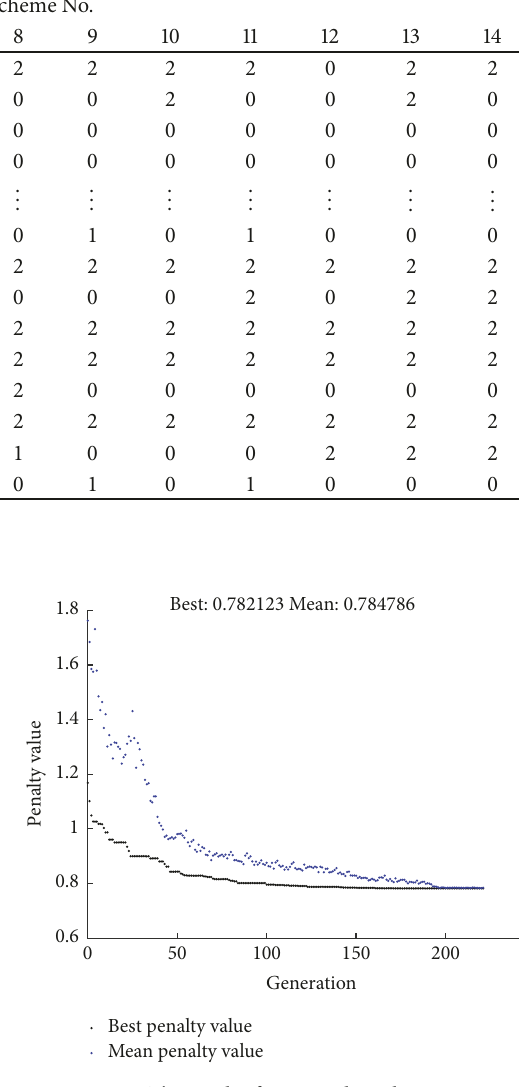
Figure 6: The result of genetic algorithm